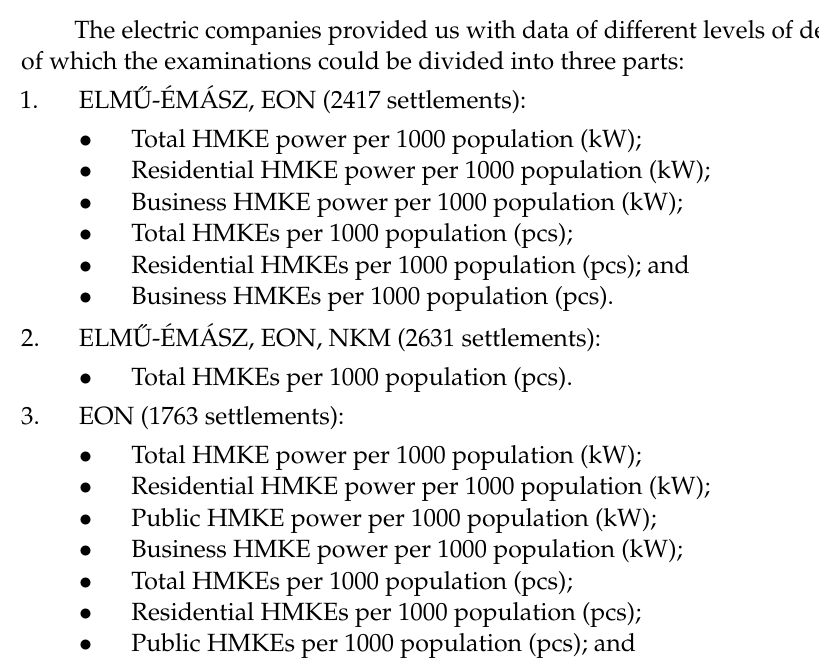
Figure 3. The regions of the Hungarian electric companies based on [41].